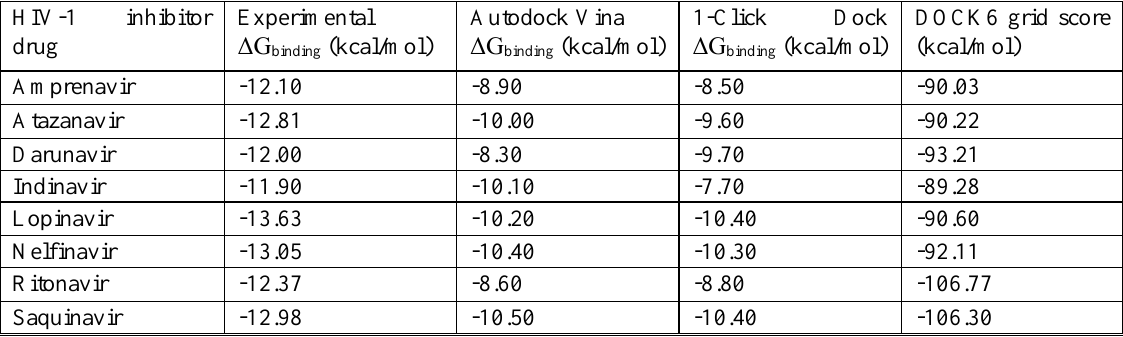
Table 2. Experimental and calculated binding free energy using Autodock Vina, 1-Click Docking, and UCSF DOCK6 programs (40-42)